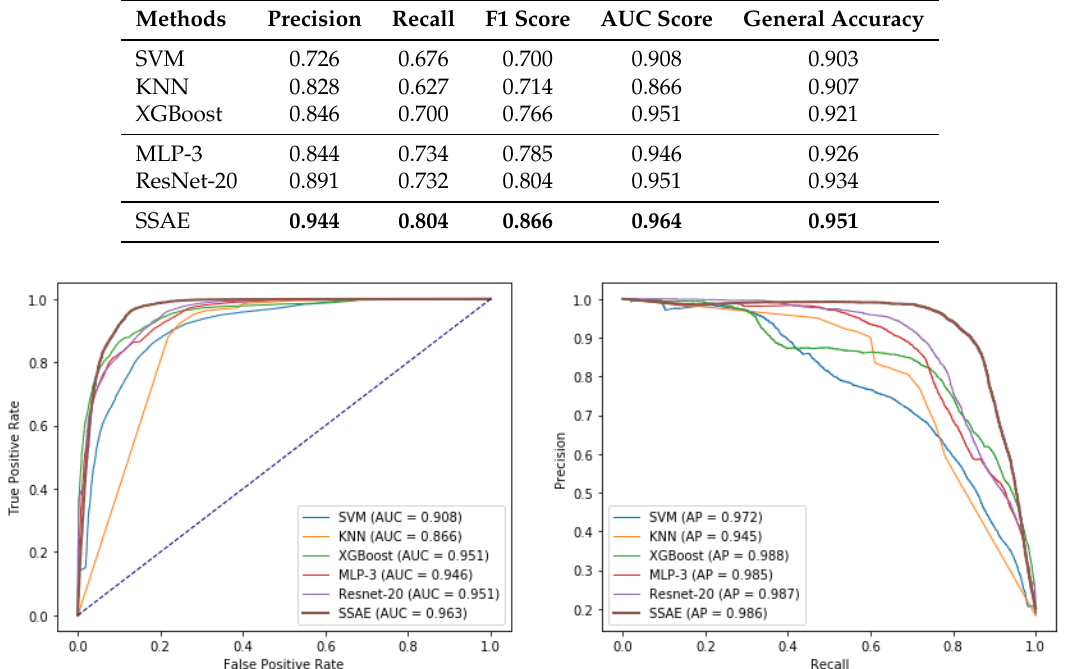
Figure 10. The ROC curve and PR curve of SSAE and